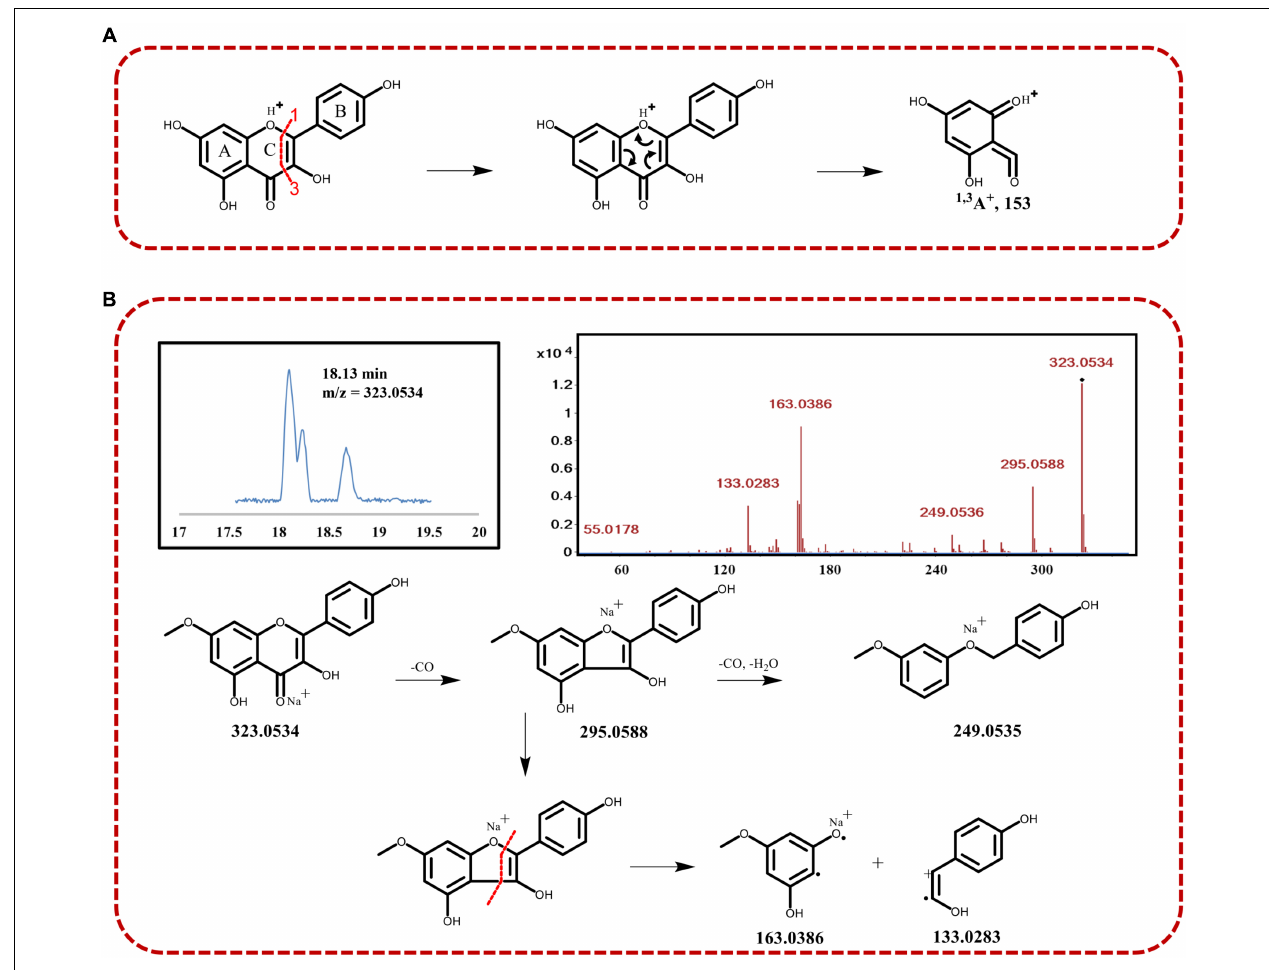
FIGURE 3 | (A) Schematic diagram of the retro Diels–Alder (RDA) fragmentation at the 1–3 bonds of the C-ring of kaempferol under collision-induced dissociation. (B) Identification of compound 16 with TIC, MS2 assays, and the fragmentation